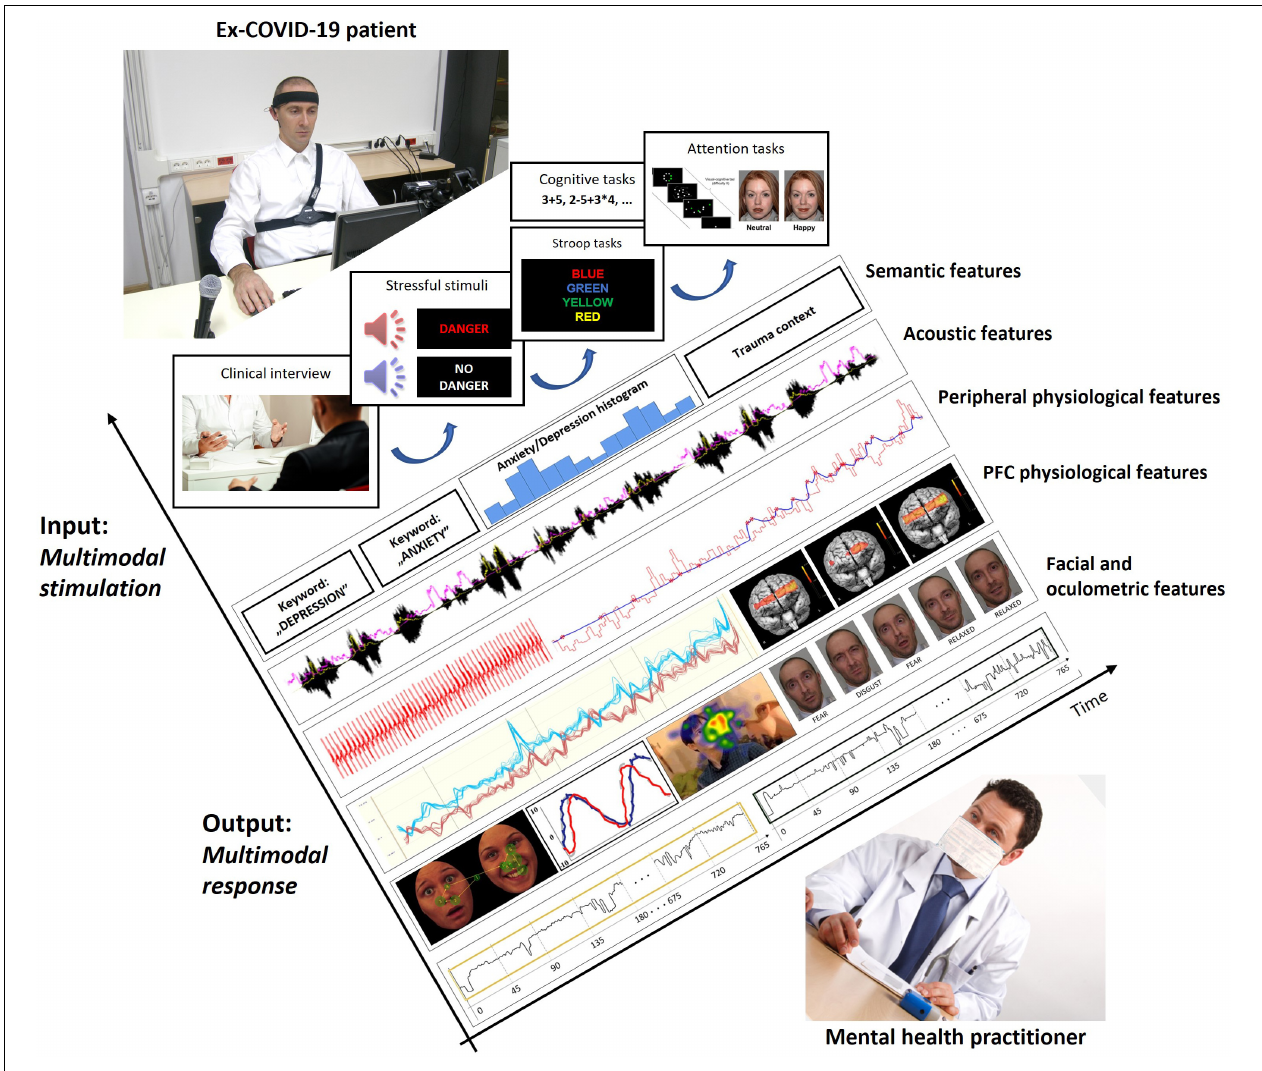
FIGURE 1 | Illustration of time-synchronized multimodal input stimulation and multimodal output response of ex-COVID-19 patient during prediction